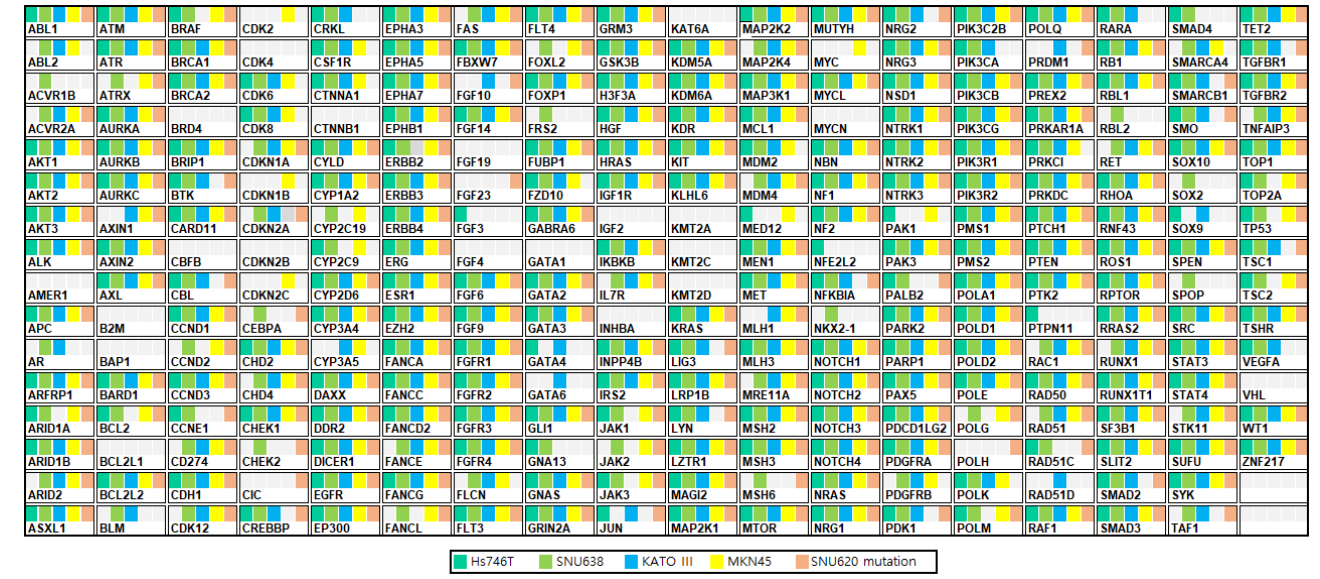
Figure 1. Gene mutations in human gastric cancer cells measured using a targeted next-generation sequencing (NGS) panel. Excel was used to generate Figure 1. Table 2. Description and concomitant genomic alteration of individual cells.